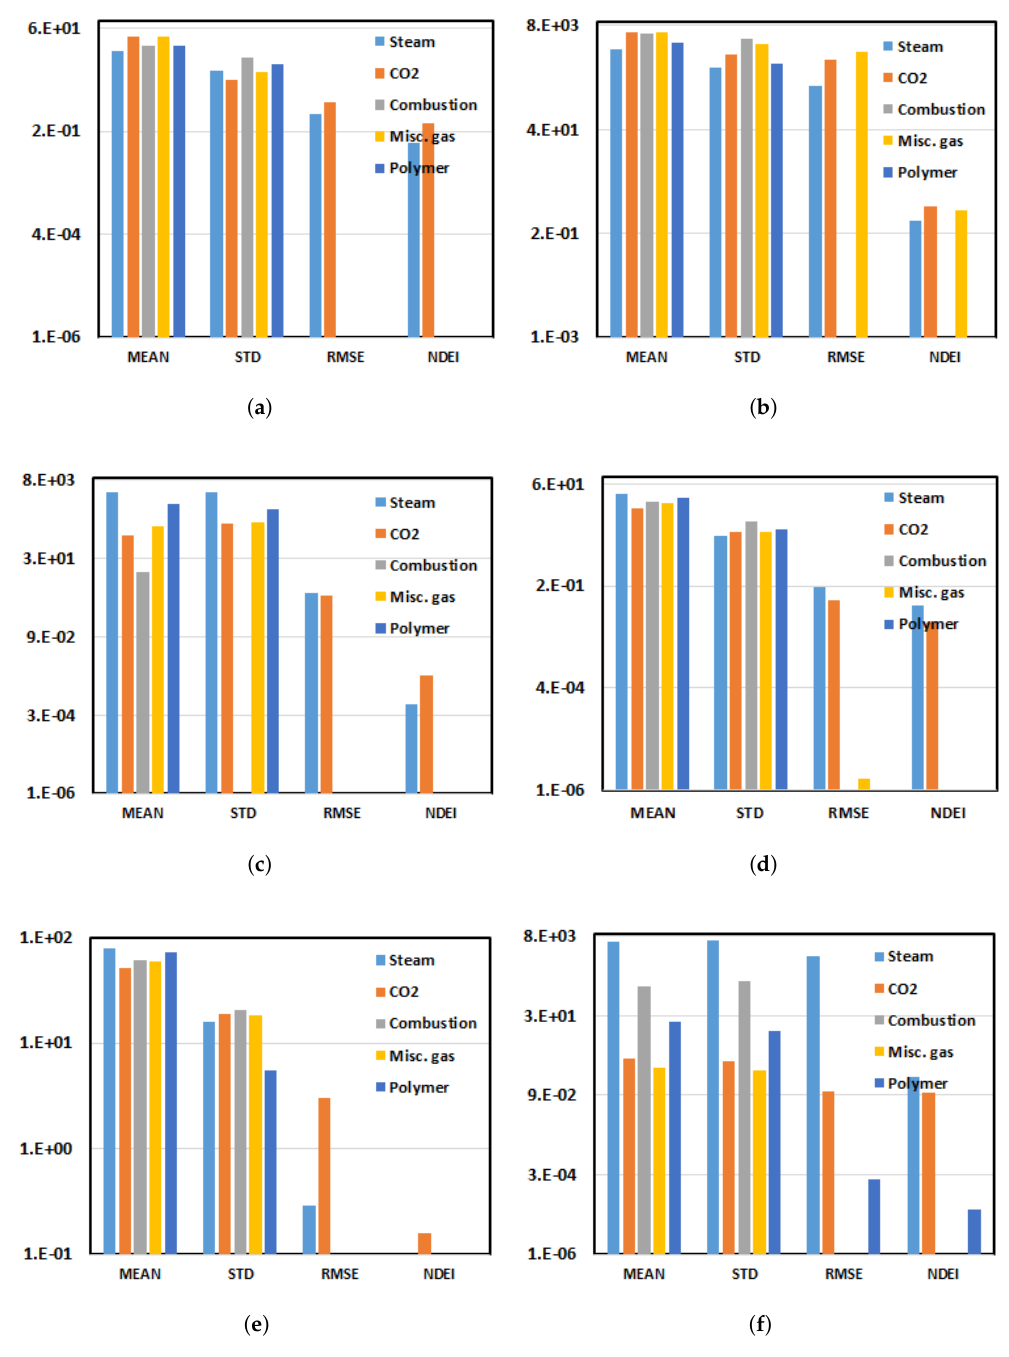
Figure A6. Statistical data plots of steam, CO 2 , combustion, miscible gas and polymer injection for Area 1 of the Angolan oilfield (See Table 4 for the area clarification). Variables include: ( a ) API; ( b ) depth; ( c ) permeability; ( d ) porosity; ( e ) saturation; and ( f )